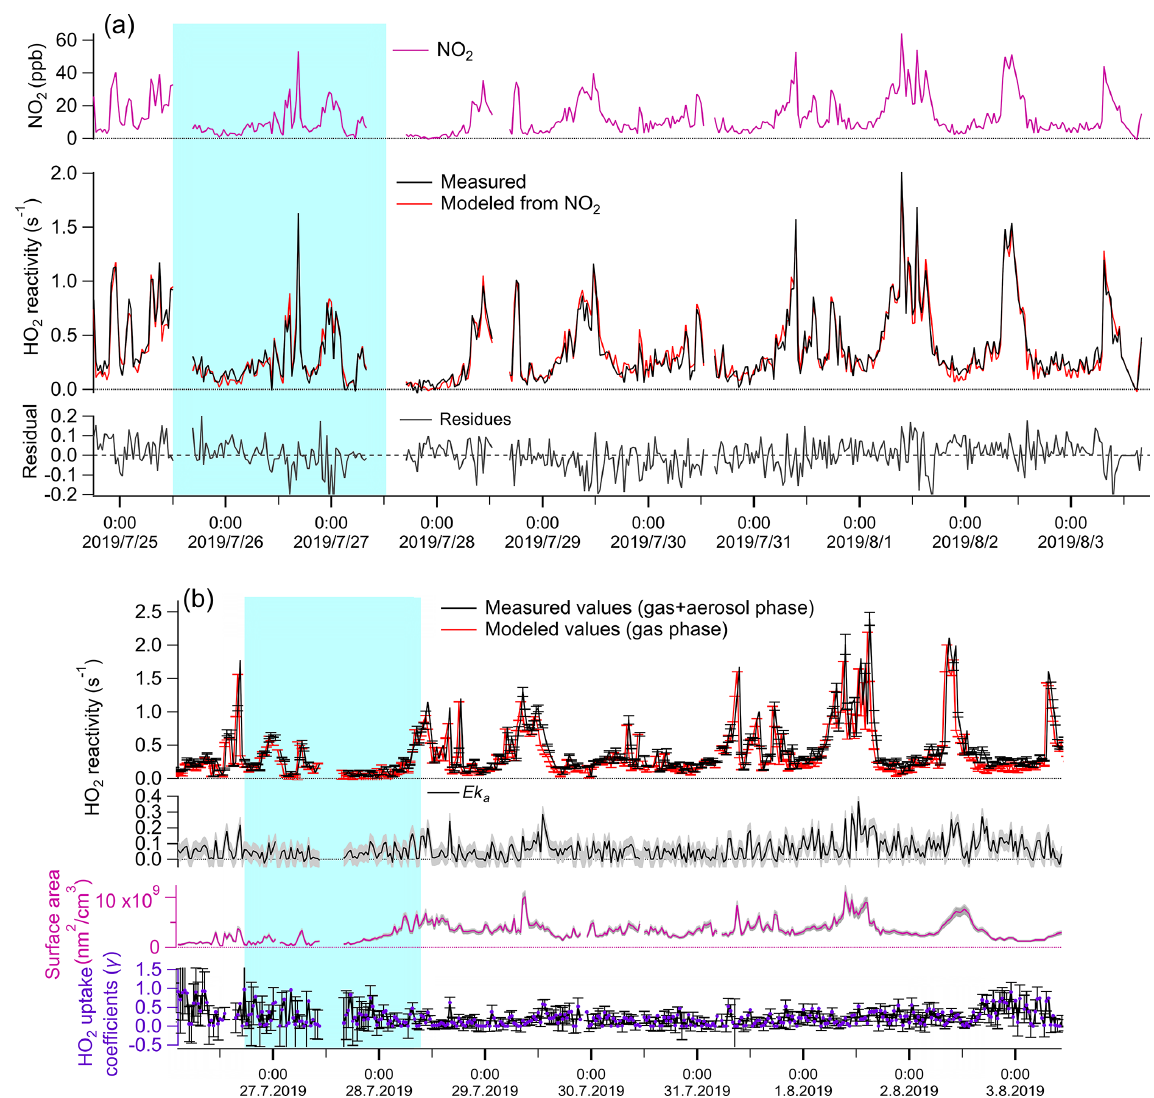
Figure 1. Temporal variation of parameters under different experimental conditions. (a) Without aerosol phase: first panel: measured NO 2 concentrations (ppb); second panel: measured (red line) and modeled (black line) k g ; third panel: fitting residues of modeled k g values, ranging from − 0.04 (25th percentile) to 0.05 (75th percentile). Therefore, we consider the systematic error of the LFP–LIF instrument to be ∼ 0.05s − 1 . (b) Gas + aerosol phase: first panel: measured total HO + Ek a ) and modeled k g ; second panel: Ek a , calculated from 2 reactivity ( k g the difference between the measured and modeled values from the first panel; the gray shadow area represents the uncertainty of Ek a ( (cid:49) Ek a ), propagated from the error of ( k g + Ek a ) and modeled k g ; third panel: the upper-limit surface area of the enriched ambient aerosols ( E S): the gray shadow area represents the uncertainty of E S ( (cid:49)E S), propagated from the systematic errors of the SMPS instrument ( ∼ 8%), and the uncertainty of the enrichment factor; fourth panel: γ calculated from Ek a and E S according to Eq. (2). The errors for γ were propagated (cid:113) 2 2 + (cid:49)E S (cid:49)Ek a from (cid:49) Ek a and (cid:49)E S, (cid:49)γ = γ × . The blue shaded area represents the air masses from group i (from the coast), and the Ek a E S remainder is from group ii (from the